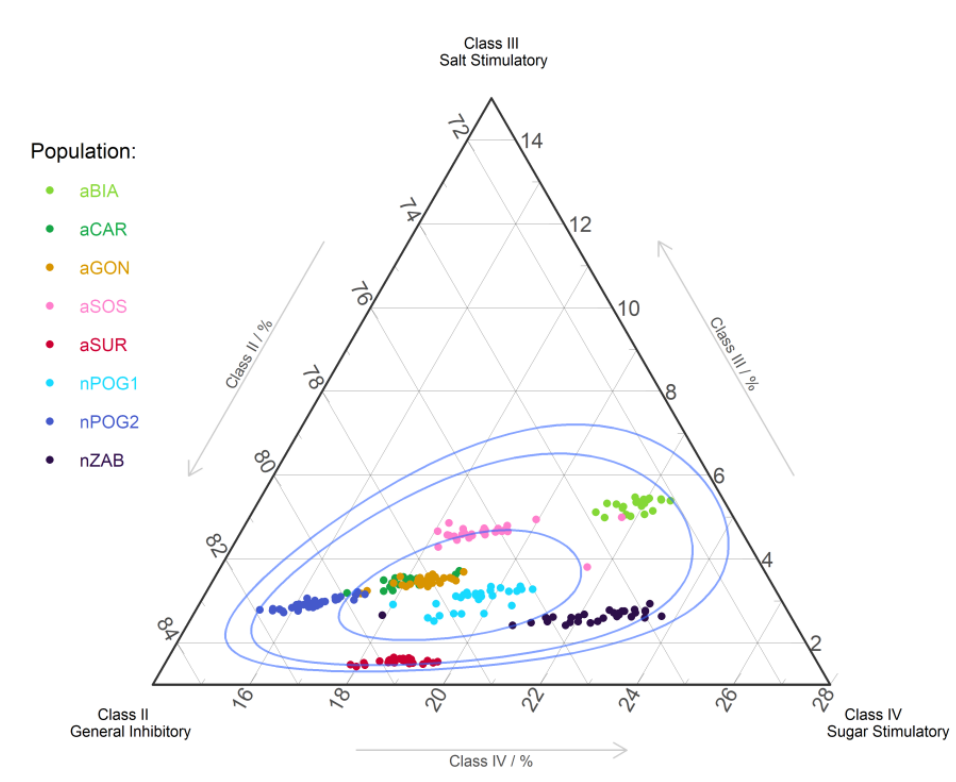
Figure 3. Ternary plot of amino acid classes for anthropogenic (aBIA, aCAR, aGON, aSOS, and aSUR) and natural (nPOG1, nPOG2, and nZAB) populations of Epipactis helleborine : II (Asp, Glu, His, Arg, and Lys), III (Pro), and IV (Val, Met, Trp, Phe, Ile, and Leu). The blue lines show the 50%, 90%, and 95% confidence intervals using the Mahalanobis distance and the log-ratio transformation. The first class of AAs (Asn, Gln, Ala, Cys, Gly, Ser, Thr, and Tyr) does not affect the chemoreceptors of the fly (data not